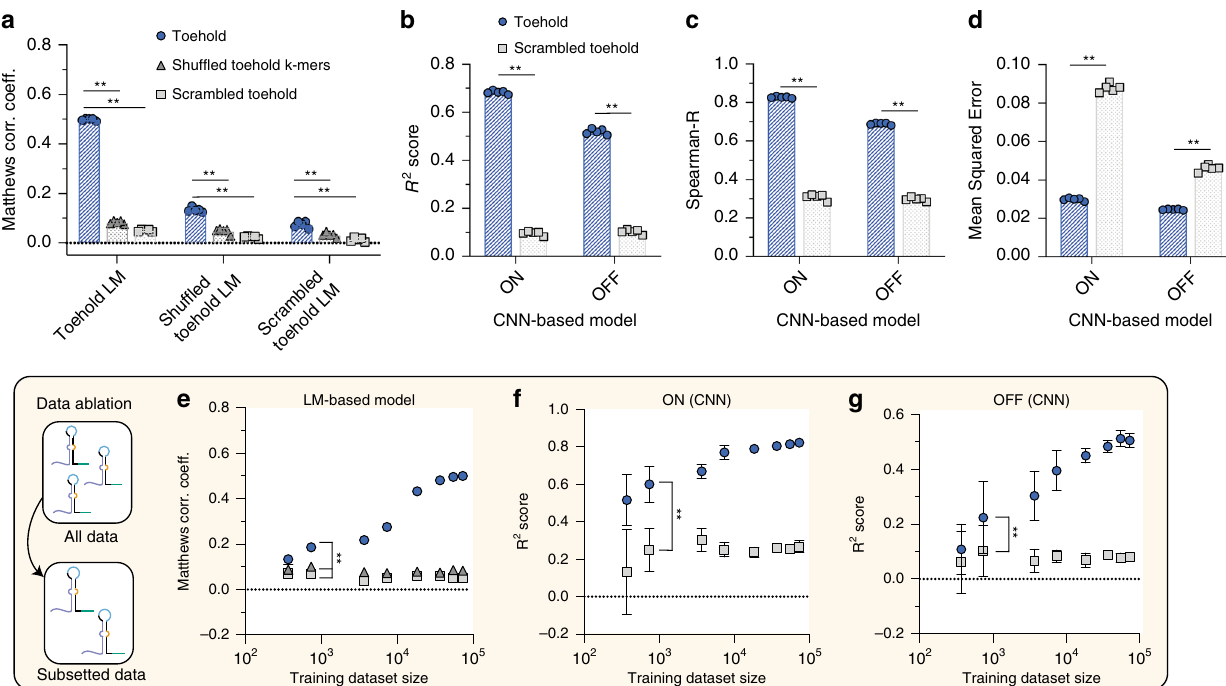
Fig. 3 Models can accurately predict toehold performance with sparse data. a The language model (LM) trained on toehold embeddings only accurately classi fi es real toeholds (blue circle), not shuf fl ed (gray triangle, p = 2.45 × 10 − 14 ) or scrambled sequences (gray square, p = 5.03 × 10 − 15 ), as assessed by Matthews Correlation Coef fi cient (MCC). While language models trained on shuf fl ed toeholds and scrambled toeholds are also more accurate for real than shuf fl ed ( p = 1.18 × 10 − 6 , p = 4.41 × 10 − 4 ) and more accurate for real than scrambled toeholds ( p = 1.58 × 10 − 8 , p = 2.01 × 10 − 5 ), they fail to achieve the accuracy of the LM trained on real toeholds. b The convolutional neural network (CNN)-based model predictions for both ON and OFF are signi fi cantly higher than predictions on scrambled toeholds in fi ve-fold cross validation, evaluated with R 2 for ON and OFF ( p = 2.97 × 10 − 14 , p = 4.19 × 10 − 12 ), c Spearman correlation ( p = 1.46 × 10 − 12 , p = 9.09 × 10 − 13 ), and ( d ) MSE ( p = 9.59 × 10 − 12 , p = 2.12 × 10 − 9 ). For ( a – d ), N = 5 cross validation folds. e Data ablation studies were performed with both the LM and CNN-based model, evaluating both real toeholds (blue circle), shuf fl ed sequences (gray triangle) and scrambled sequences (gray square). LM performance does not drop off steeply with half as much data and continues to perform better on real vs. shuf fl ed ( p = 9.23 × 10 − 9 ) and real vs. scrambled ( p = 6.65 × 10 − 10 ) with just 736 training examples. For ( e ), N = 5 trials. f Similarly, the CNN-based model performance does not drop off steeply for either ON or ( g ) OFF prediction with half as much data and has signi fi cantly different R 2 values at a training size of 736 samples for both ON and OFF predictions ( p = 7.23 × 10 − 7 , p = 0.028). For ( f , g ), N = 10 trials. For all panels, error bars represent mean ± standard deviation and all tests are two-tailed